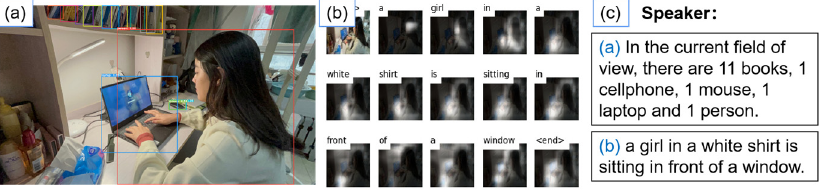
Figure 16. Comparison of the results of object detection and image captioning. ( a ) Object detection processed result. ( b ) Image captioning processed result. ( c ) Comparison of the two